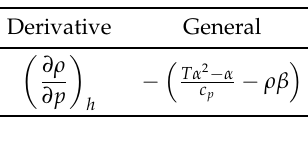
Table A4. Constant Enthalpy.